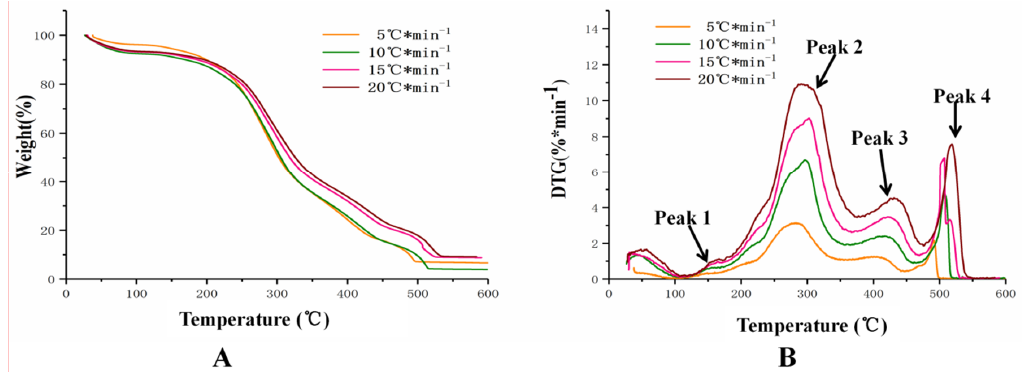
Figure 4. The TG-DTG curves of PT at four different heating rates. Notes: ( A ) was TG curves and ( B ) was DTG curves